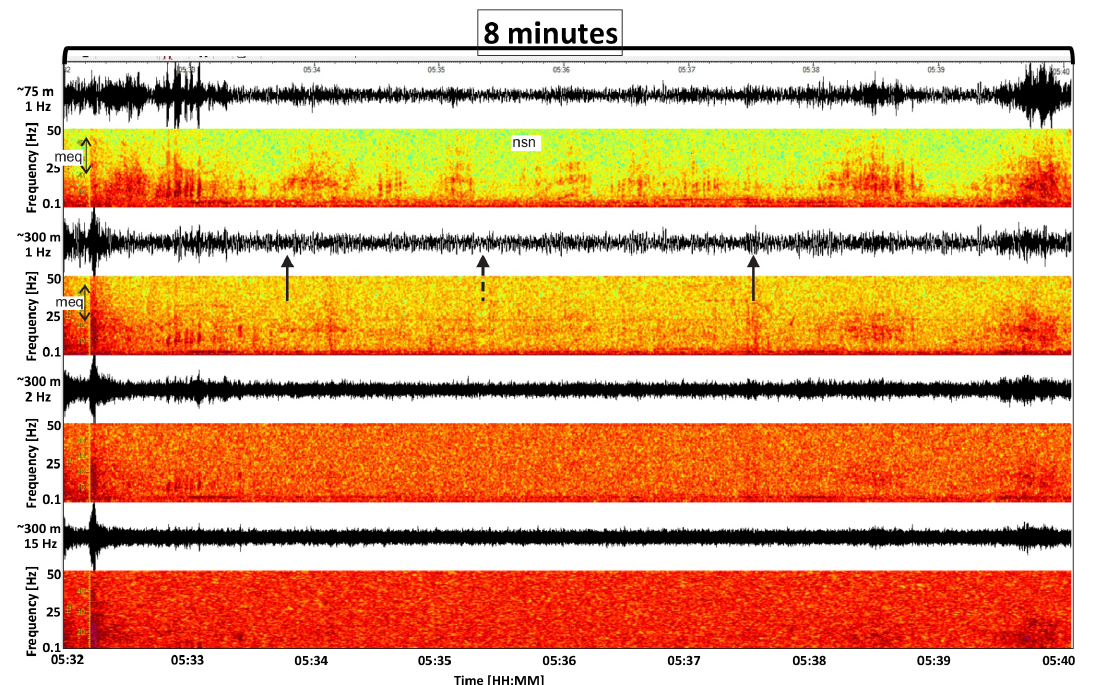
Figure 6. Seismograms and spectrograms illustrating the increasing attenuation of near-surface noise with depth and the increasing mi- croearthquake signals with depth. The depth and natural frequency of the vertical component sensors used to record these motions are shown on the left. The data window is for the 8min between the main foreshock and the M w 4 . 2 Yelova earthquake, as shown in Fig. 5. The 500 samples/second seismograms have been band pass filtered between 0.1 and 50Hz, and normalized to matching maximum values. The spectrogram bandwidths shown are also between 0.1 and 50Hz, and their color scales were adjusted to matching maximum values and ranges. Examples of the difference between downgoing near-surface noise ( nsn ) and upcoming microearthquake signal ( meq ) attenuation are labeled. For example, the near-surface noise recorded during the lower time bar on the ∼ 75m deep 1Hz vertical is nearly absent on the ∼ 300m deep sensors; likewise for the signals on either side at the time of 05:33:00. In contrast, the high-frequency microearthquake signal at the beginning of the record on the ∼ 300m 1Hz is similarly reduced on the ∼ 75m deep sensor. Potential smaller microearthquakes not evident on the ∼ 75m deep recording are indicated by black arrows on the ∼ 300m 1Hz spectrogram, and are at the detection limit of the GONAF stations. The self-noise floor and sensitivity of the 1Hz sensor are clearly evident in these plots: the higher-frequency sensors pick up the first microearthquake event, but the other events are buried by their overall system-response